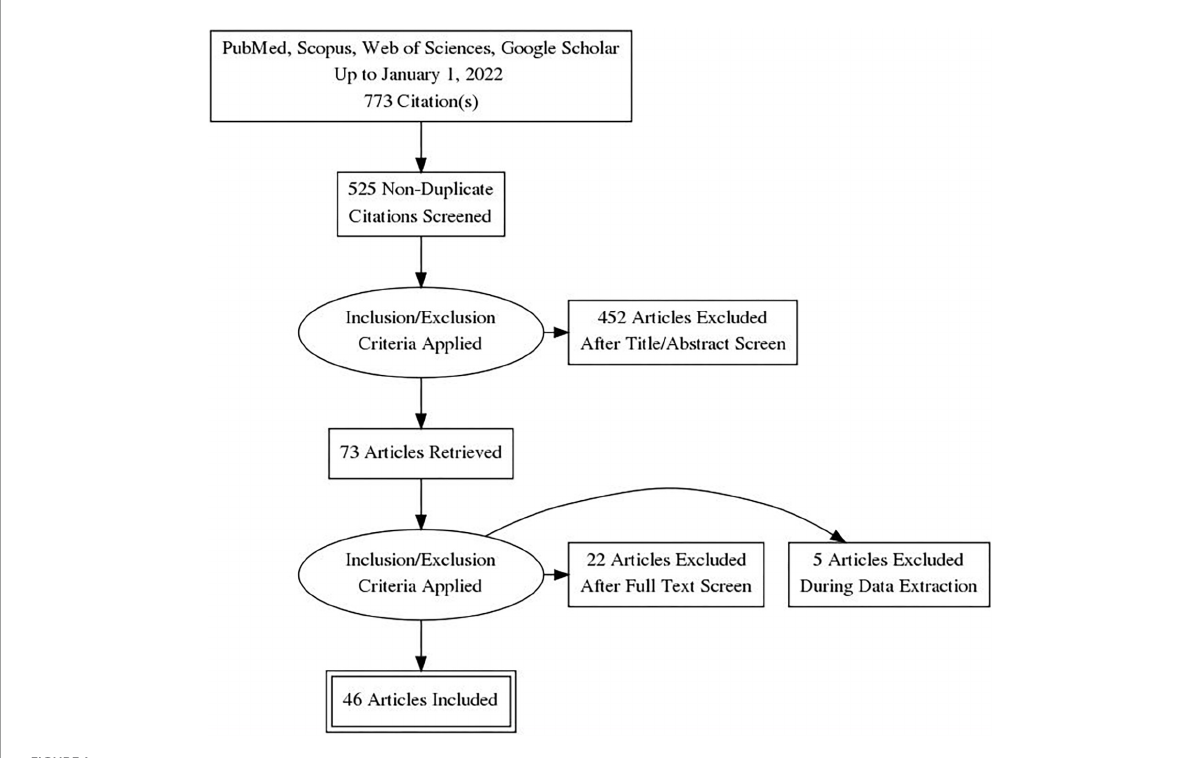
FIGURE1 PRISMA flow